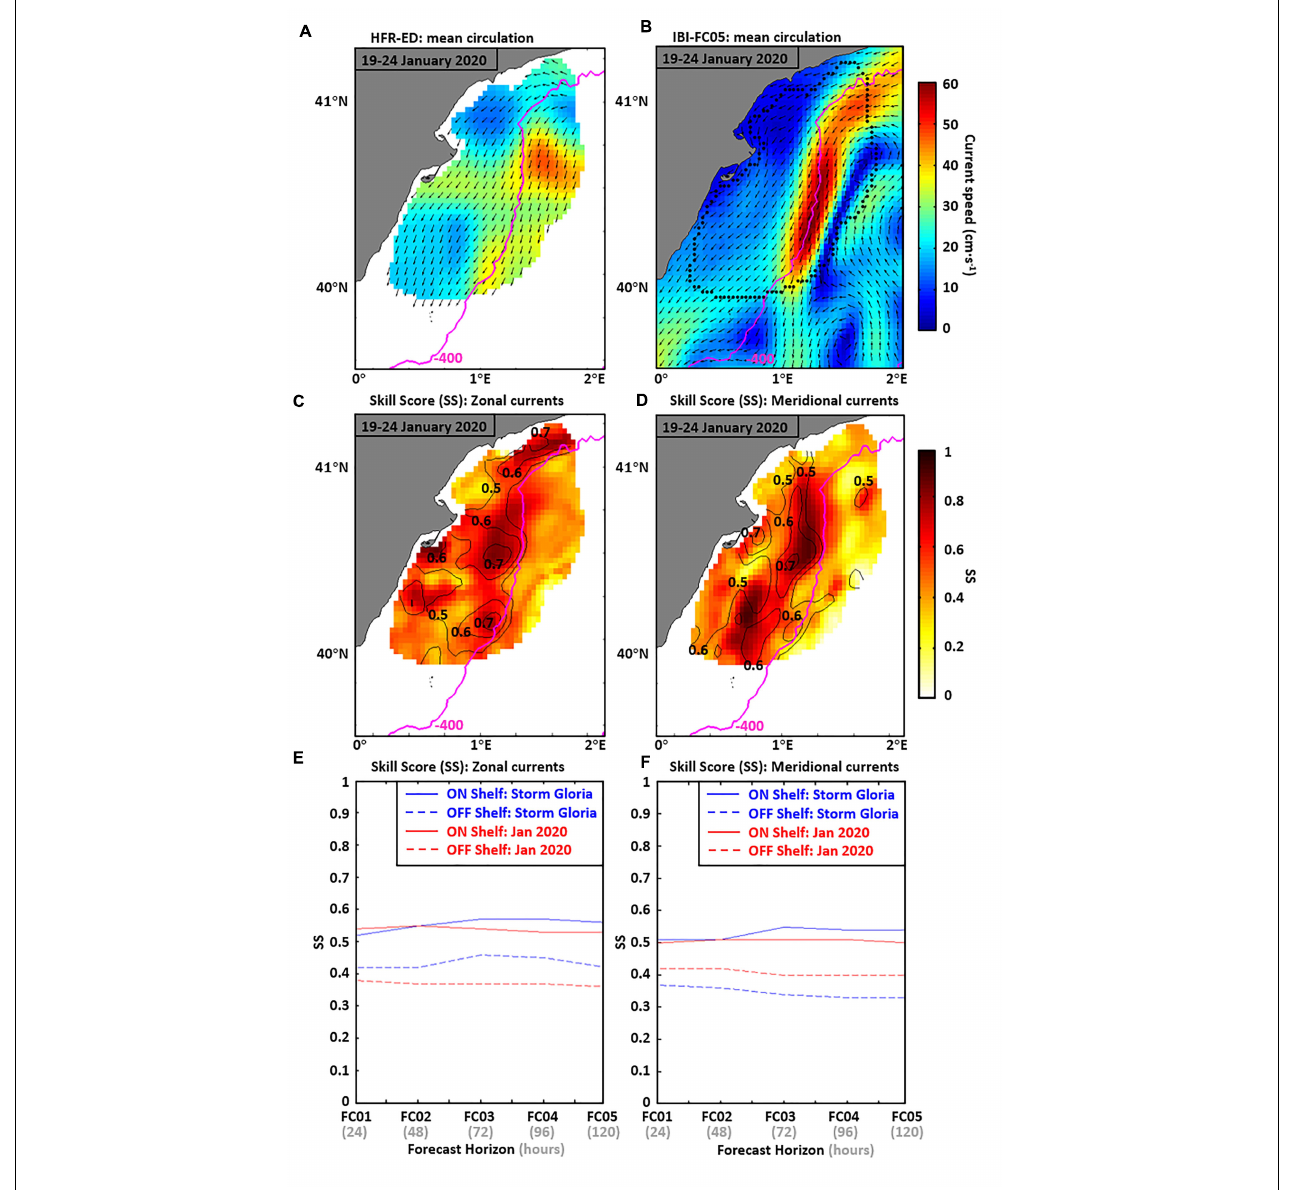
FIGURE 6 | Six-day averaged maps of the surface currents as derived from hourly HFR estimations (A) and IBI outcomes five days ahead (B) during storm Gloria. Current vectors are normalized. The magenta bathymetric contour shows depths at 400 m, splitting off-shelf regions from on-shelf areas. Maps of the spatial distribution of the Skill Score (SS) for the zonal (U) (C) and meridional (V) (D) current velocity: colors (isolines) denote the values obtained during storm Gloria (the entire month of January). SS, spatially averaged over the common domain, for each forecast horizon: zonal (E) and meridional (F) currents. Blue (red) lines indicate the SS for the Gloria event (the entire month of January 2020), spatially averaged over the shelf (solid lines) and over off-shore waters (dashed